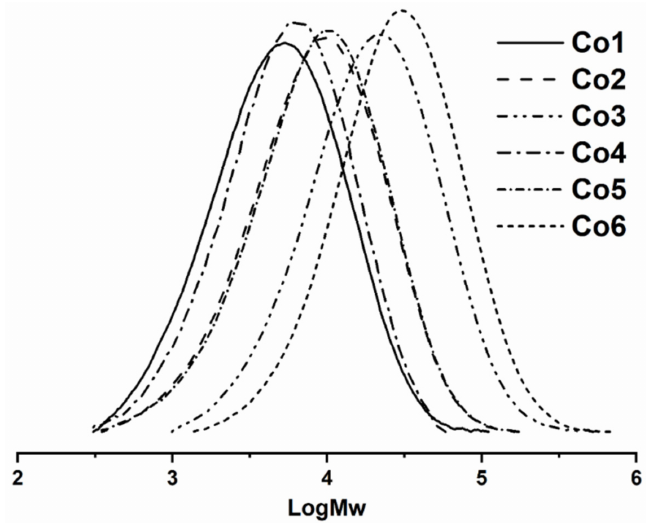
Figure 9. GPC curves showing log M w of the polyethylenes produced using Co1 – Co6 with MAO as activator in each case (runs 1–6, Table